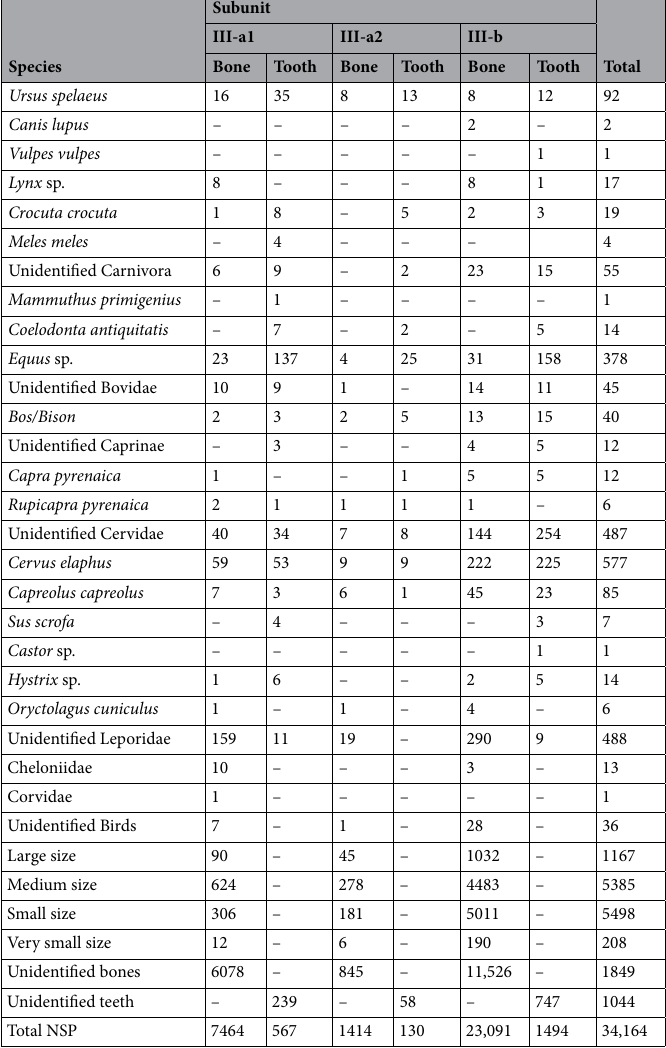
Table 5. Number of Specimens (NSP; including anatomic and taxonomically identifiable bone fragments, as well as fragments that were not attributed to a body-size class) and teeth by subunits III-a1, III-a2 and III-b at Teixoneres Cave.